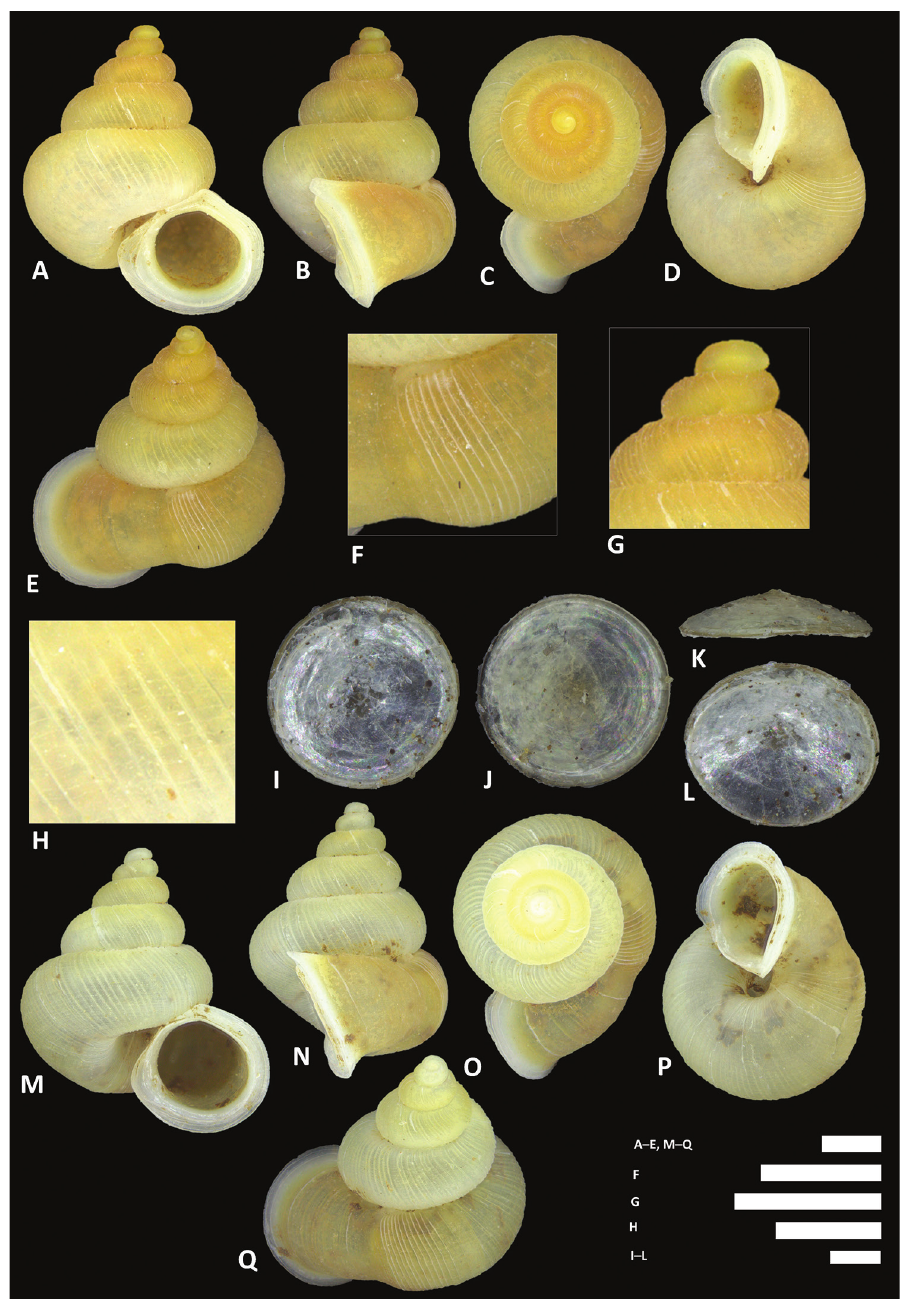
Figure 28. Alycaeus senyumensis sp. n. A–E Shell of holotype, BOR/MOL 12965 F–H Close up of shell of holotype, BOR/MOL 12965 I–L Operculum of paratype, BOR/MOL 6880 M–Q Shell of paratype, operculum of BOR/MOL 12966. Scale bars: A–E, F, G, M–Q 1 mm; H, I–L 0.5 mm. All photographs by Junn Kitt